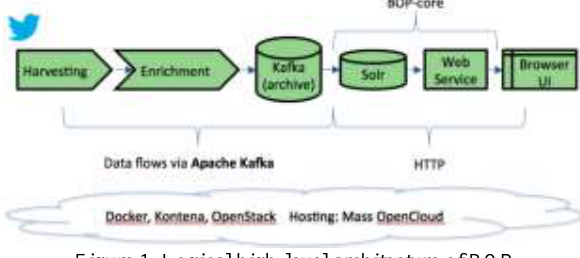
Figure 1. Logical high-level architecture of